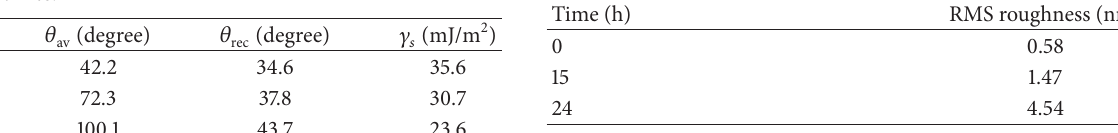
Table 1: Values of wetting contact angles and apparent surface energy for as-prepared SinA monolayer and under different UV irradiation times.